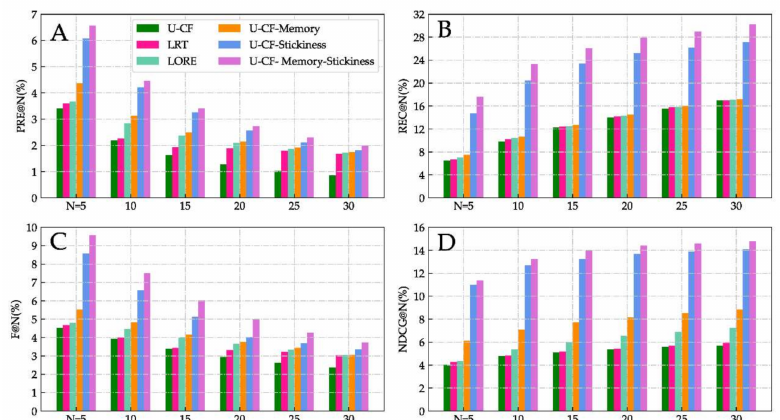
Figure 4. Comparison of recommendation performance under different N . ( A ) Precision ( PRE @ N ).